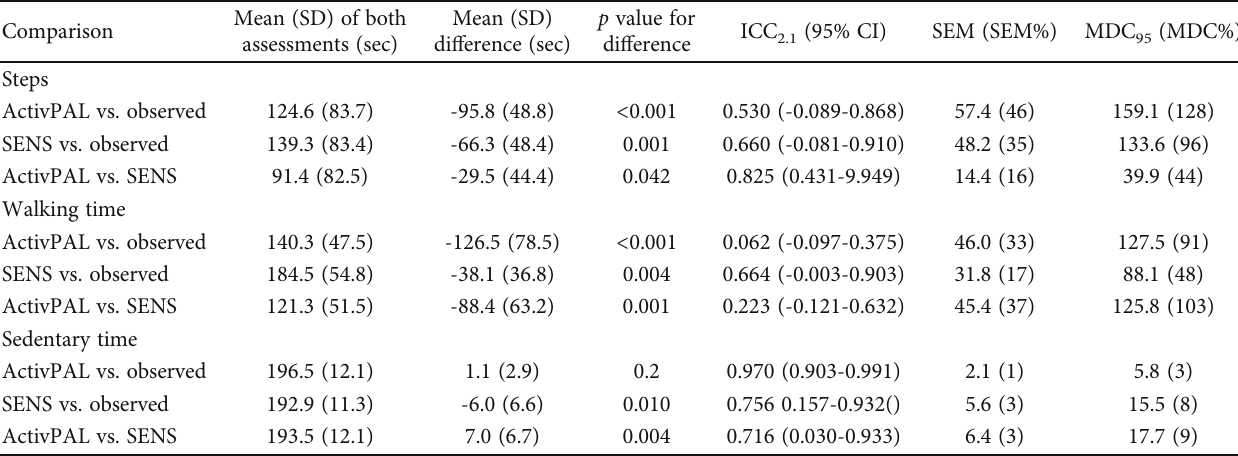
Table 8: Relative and absolute reliability of steps, walking, and sedentary time assessed with ActivPAL3 ™ , SENS motion®, and direct observations in older patients with hip fracture ( N = 12